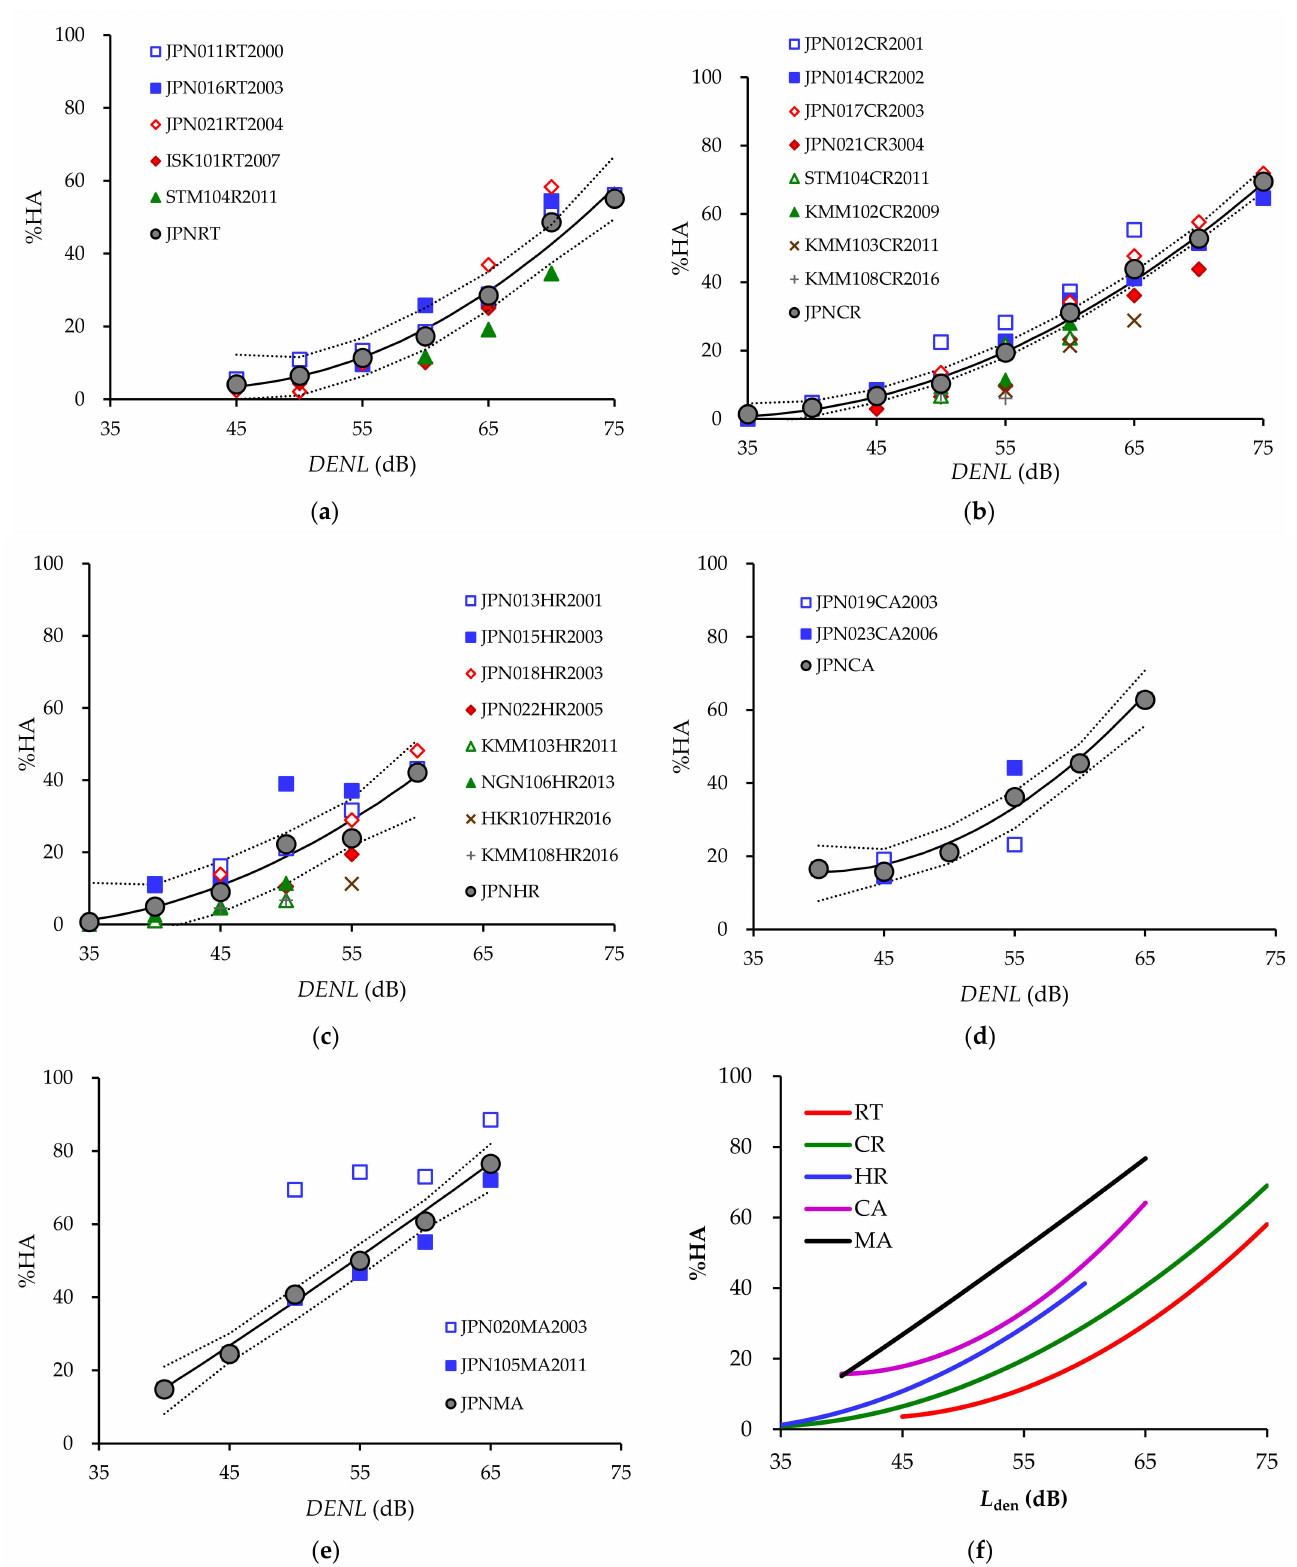
Figure 1. Estimated exposure–annoyance relationships (line) derived from aggregated data and data-points derived from micro-data: ( a ) road traffic noise; ( b ) conventional railway noise; ( c ) Shinkansen railway noise; ( d ) civil aircraft noise; ( e ) military aircraft; ( f ) comparison among transportation noises. Figure 1 ( a – e ) were plotted in 5-dB units of the noise level; Figure 1 ( f ) was drawn by interpolating the noise level in 1-dB